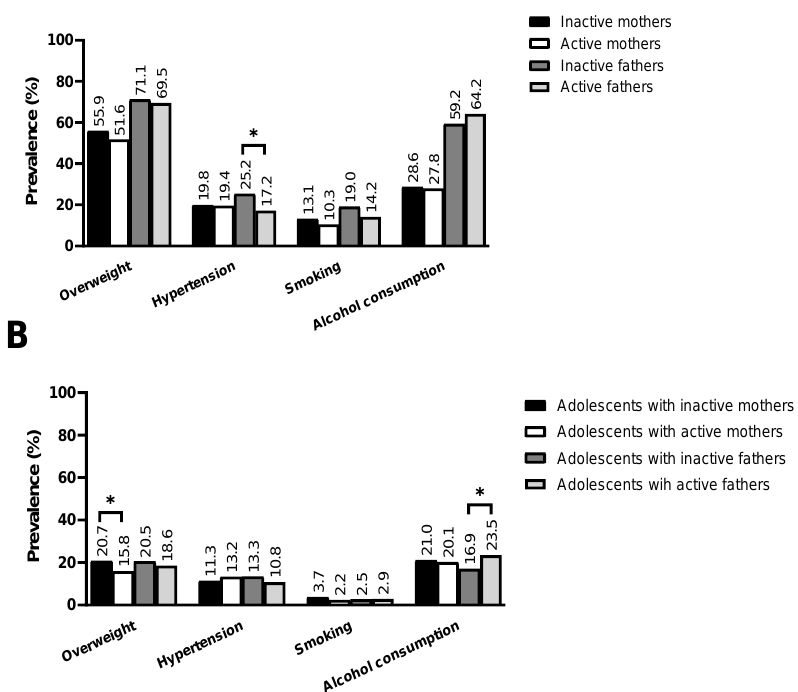
Figure 1. Prevalence of cardiovascular risk factors in parents according to their level of physical activity. * p < 0.05 for comparison of proportions by chi-square test.